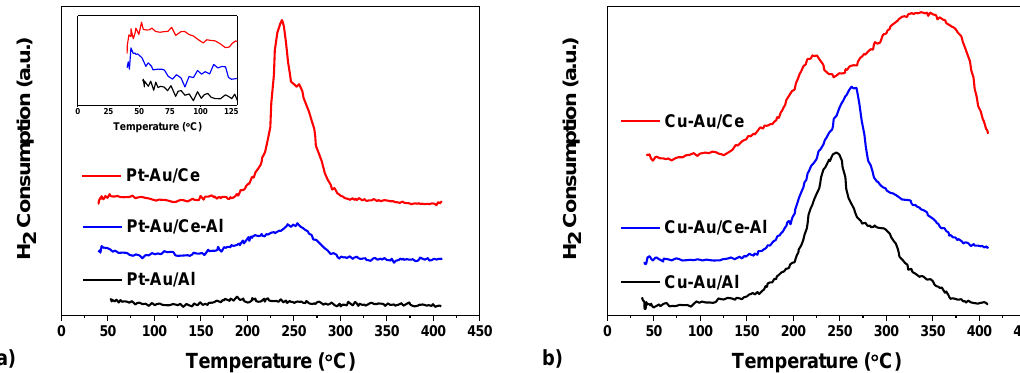
Figure 3. H 2 -TPR profiles of ( a ) Pt–Au and ( b ) Cu–Au on γ -Al 2 O 3 , CeO 2 , and CeO 2 –Al 2 O 3 supports. Total H 2 consumptions: Pt–Au / Al, 44 µ mol g − 1 ; Pt–Au / Ce–Al, 315 µ mol g − 1 ; Pt–Au / Ce, 781 µ mol g − 1 ;